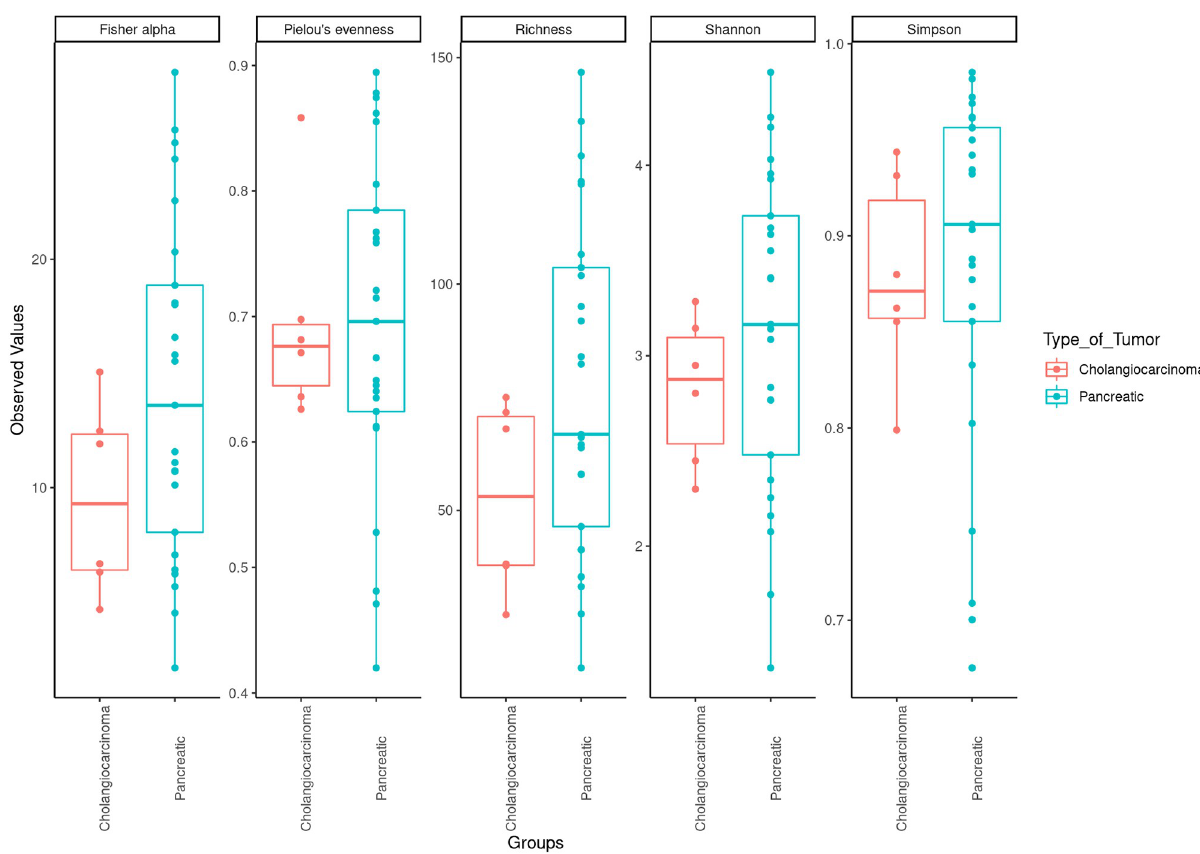
Fig 6. Alpha diversity of biliary microbiota in bile from patients with pancreatic cancer vs cholangiocarcinoma.